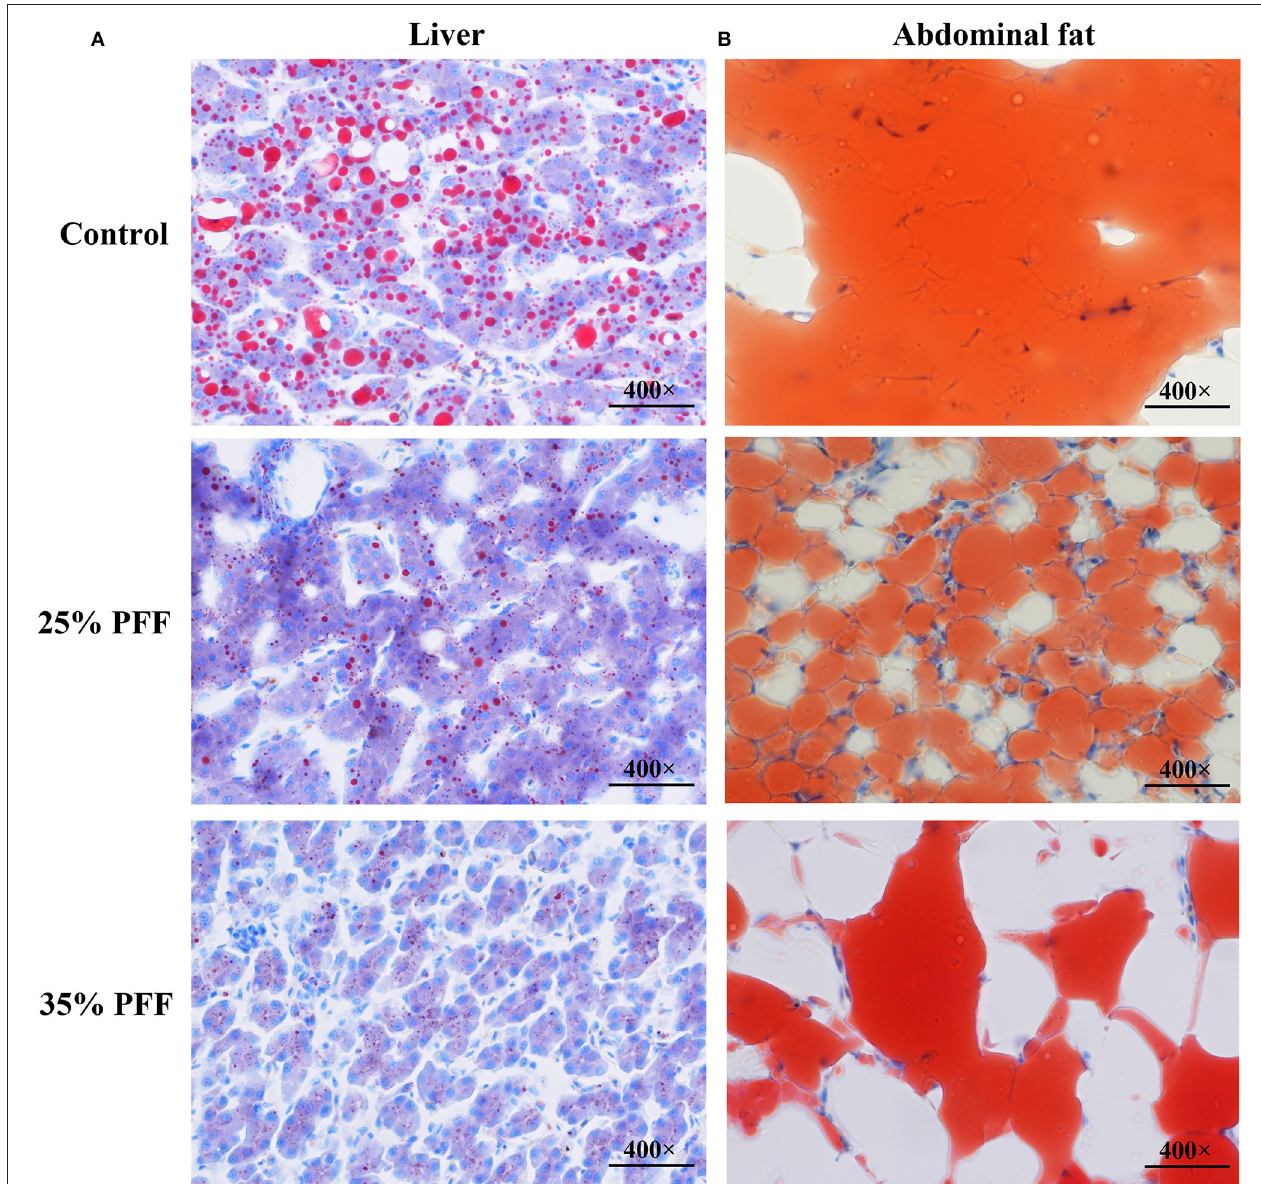
FIGURE 1 | Effect of PFF on fat accumulation in Shaoxing ducks with Oil Red O staining. (A) Liver; (B) abdominal fat. The red color indicates lipid droplet, and the blue color indicates nucleus.